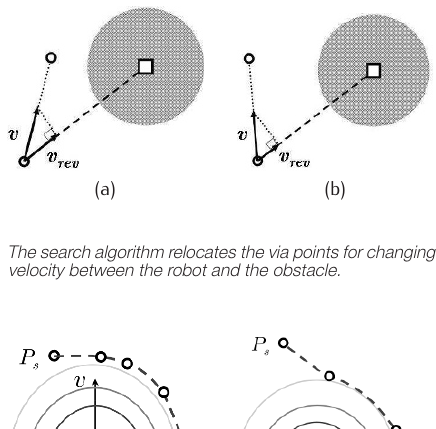
Figure 3. Desired path consists of straight lines and a circular arc.